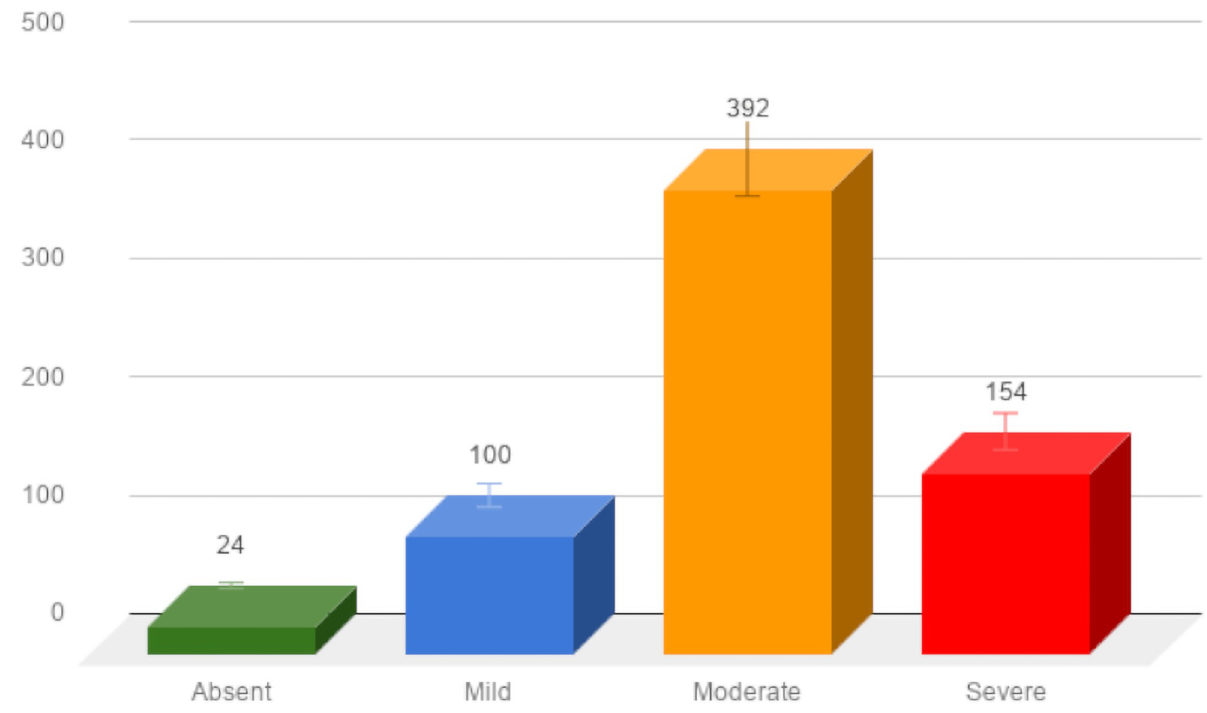
Fig 2. Distribution of student across the four nomophobia